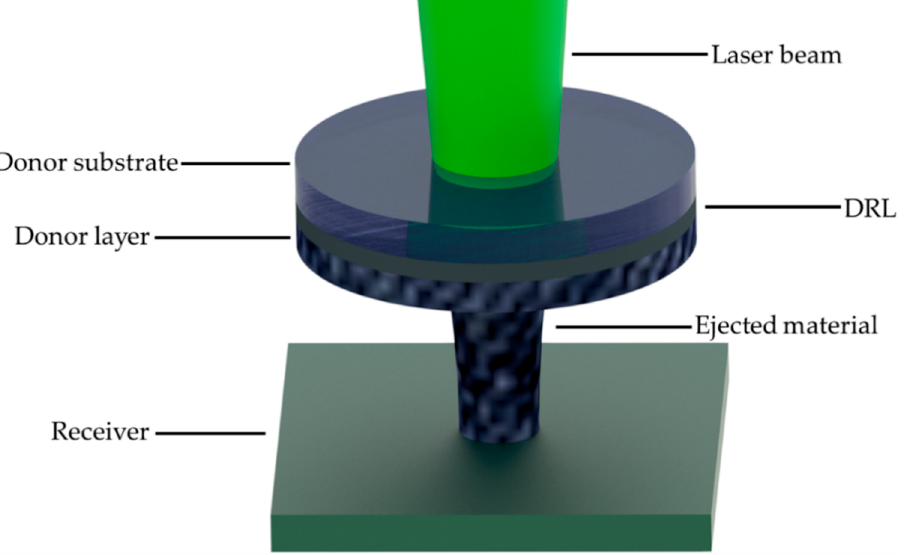
Figure 1. Schematic representation of the LIFT process of solder paste.